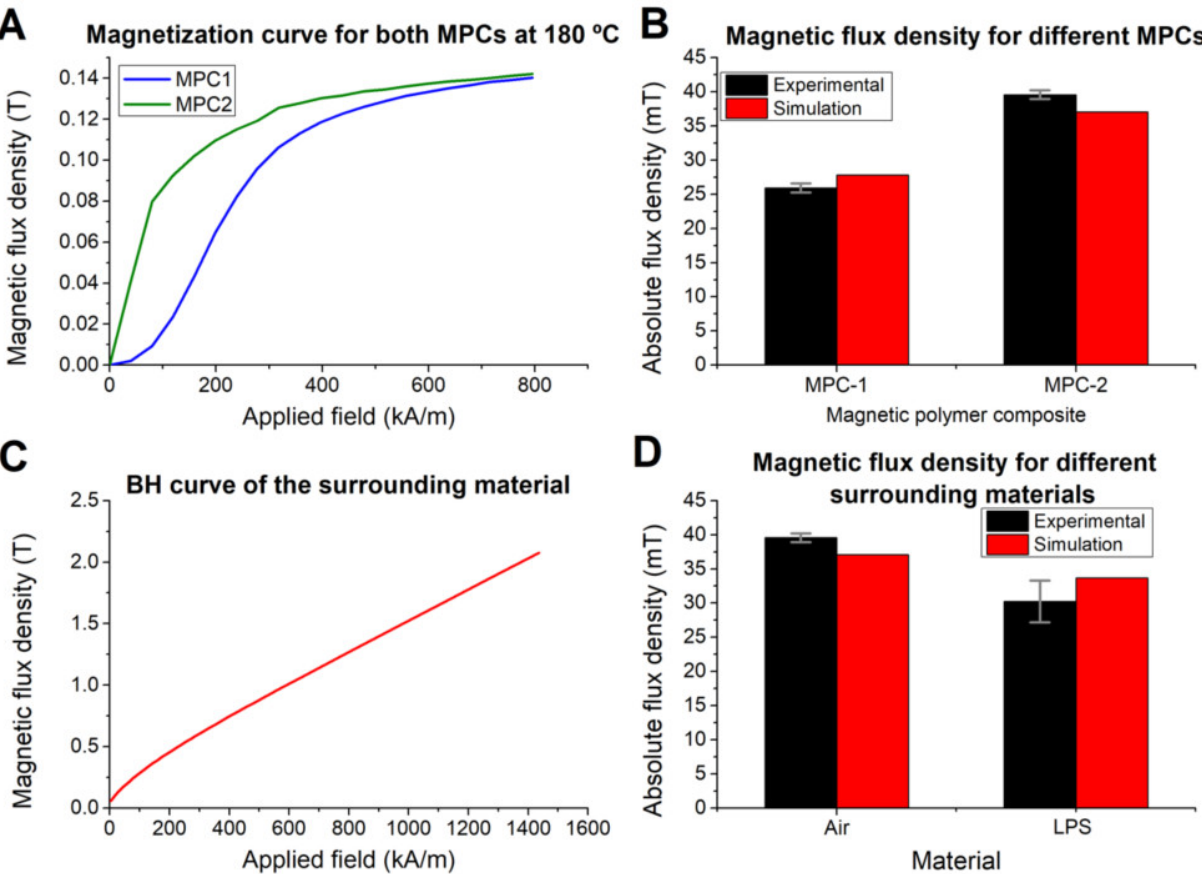
Figure 6. ( A , B ). Validation of the model for different MPCs: ( A ) initial magnetization curves for MPC-1 and MPC-2; ( B ) experimental (black bar) and simulation (red bar) magnetic flux density of the parts made of MPC-1 and MPC-2. ( C , D ). Validation of the model to predict the influence of surrounding materials: ( C ) first quadrant of the B–H curve of the low permeability steel disk used as spacer; ( D ) experimental (black bar) and simulation (red bar) magnetic flux density of the parts magnetized using an air gap or a metal disk.